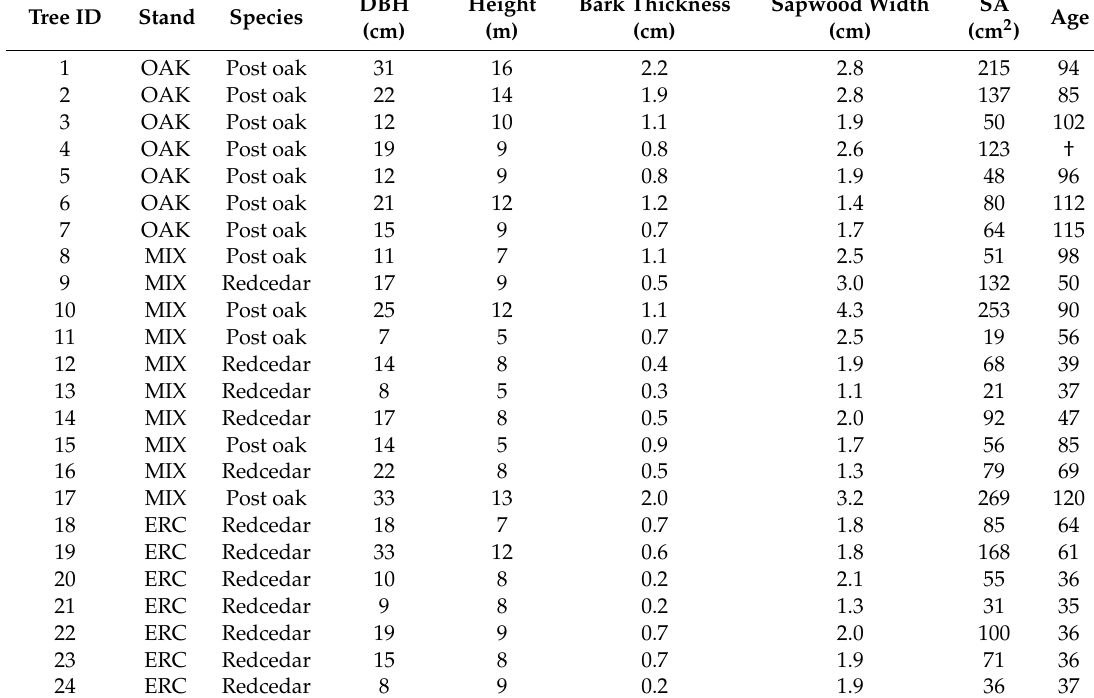
Table 1. Diameter at breast height (DBH), height, bark thickness, average sapwood width, and sapwood area (SA) of all trees instrumented with TDP. The sapwood area was calculated individually for each tree based on sapwood width. The sapwood width of each tree was estimated using one core for each oak tree (symmetric sapwood), and a di ff erent number of cores for each redcedar tree (somewhat asymmetric sapwood) depending on its size and